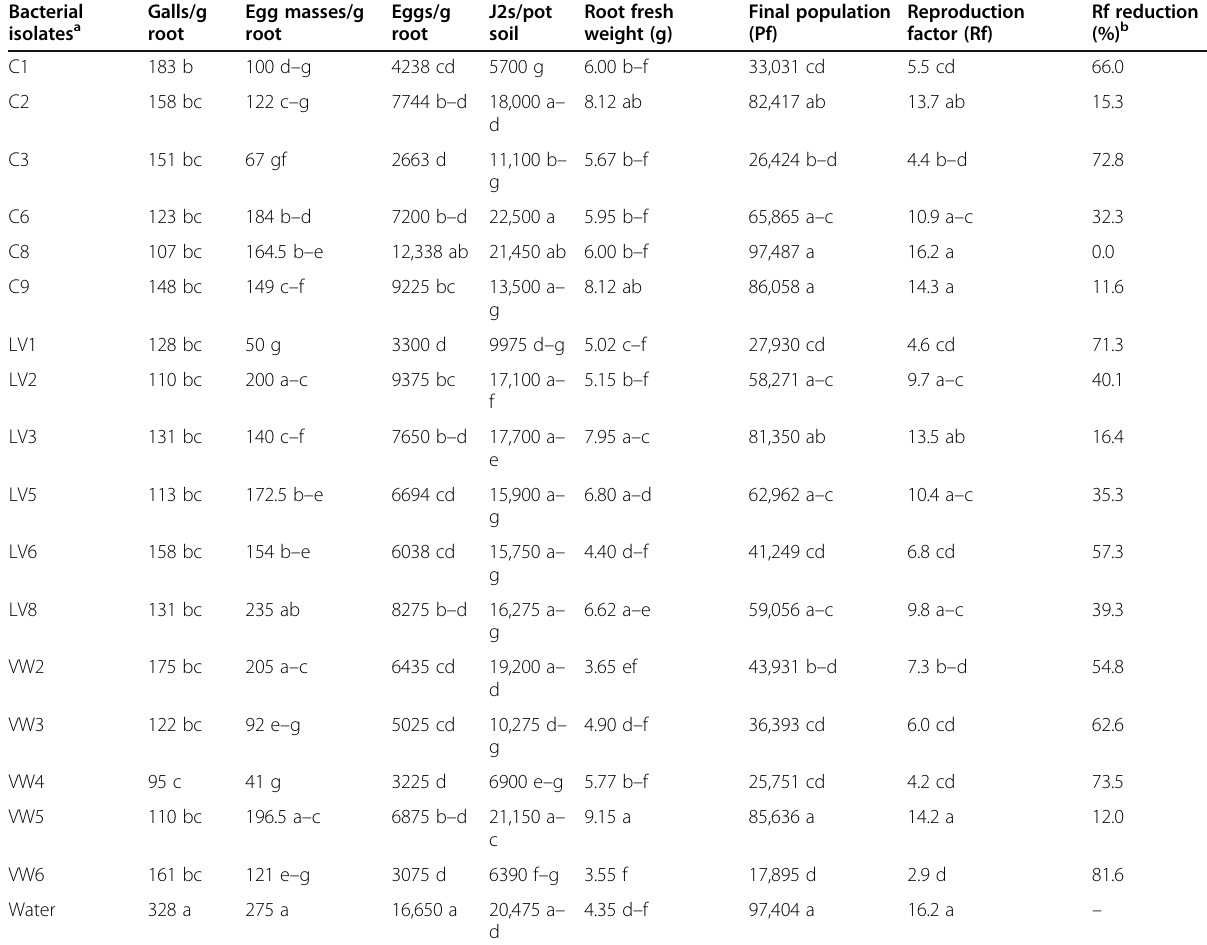
Table 1 Screening the effects of 17 bacterial isolates from vermicompost and earthworm on the nematode indices of Meloidogyne javanica in the roots of tomato plants in a glasshouse Bacterial Galls/g Egg masses/g isolates a root